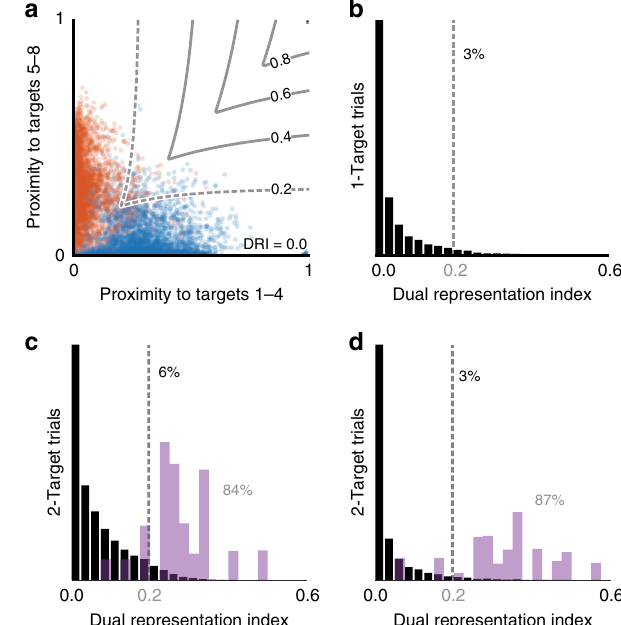
Fig. 6 Testing for dual representation in low-dimensional states. a Proximity plot of 1-Target trials for monkey C from Fig. 3c, overlaid with a contour plot of the dual representation index (DRI). b Histogram of DRI values from a . A post hoc upper threshold of DRI = 0.2 (vertical dashed line) captured all but 3% of 1-Target activity for monkey C and all but 1% for monkey M. c Histogram of DRI values for all 2-Target trials (black), monkey C. Purple bars re fl ect simulations from both the dual-target model and the averaged- plan model. d Same as c for monkey